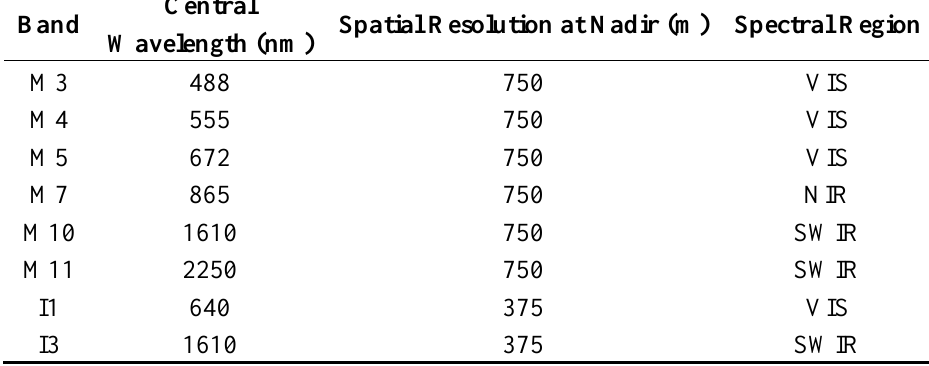
Table 1. VIIRS RSB available in the VIIRS Land PEATE AS3100 subsetted data archived at the